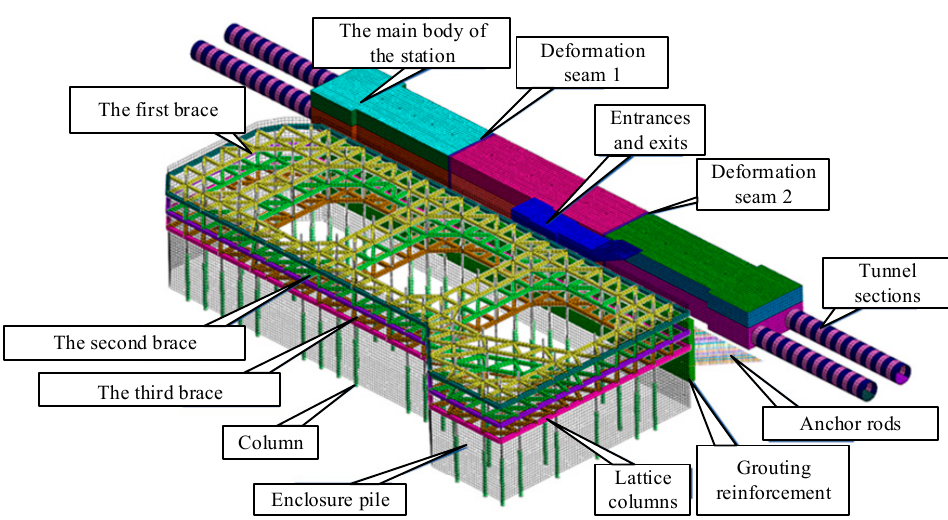
Figure 19. Schematic diagram of the model position relationship.